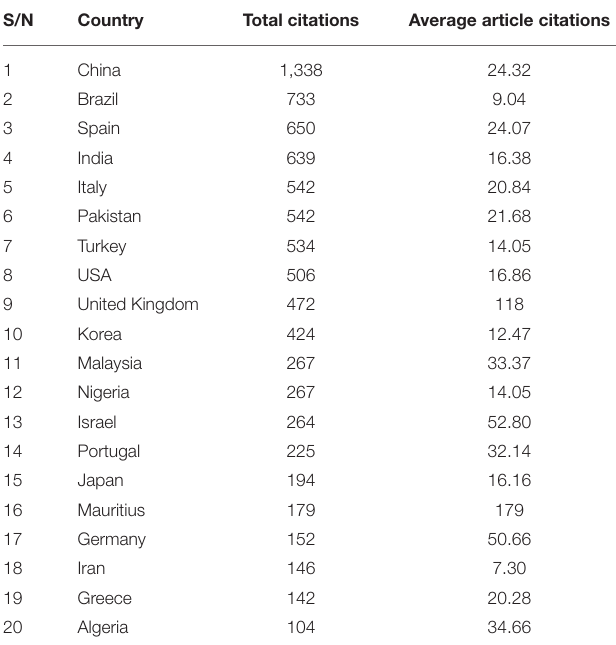
TABLE 2 | The top 20 most cited countries in terms of average article citations (AAC) in the field of citrus waste as animal feed for livestock production from